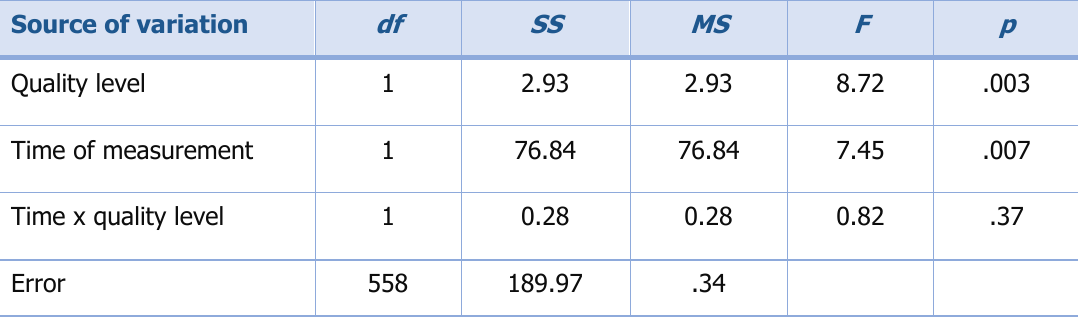
Table 6. Effects of Quality Level and Time of Measurement in Year 1 Source of